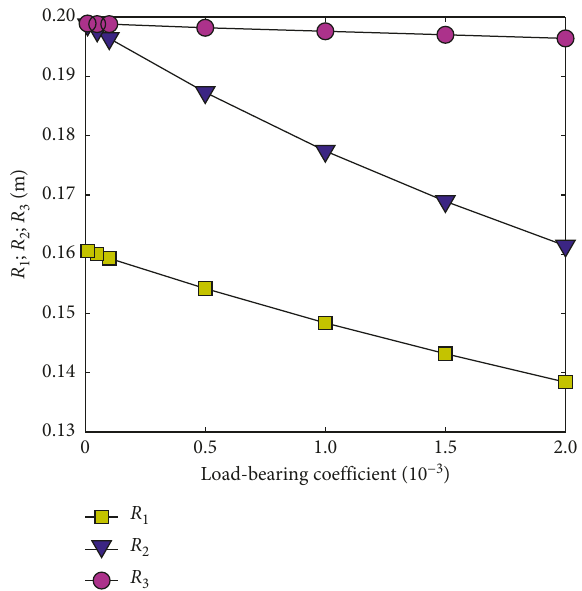
Figure 8: The radii of the postpeak failure zone under different load-bearing